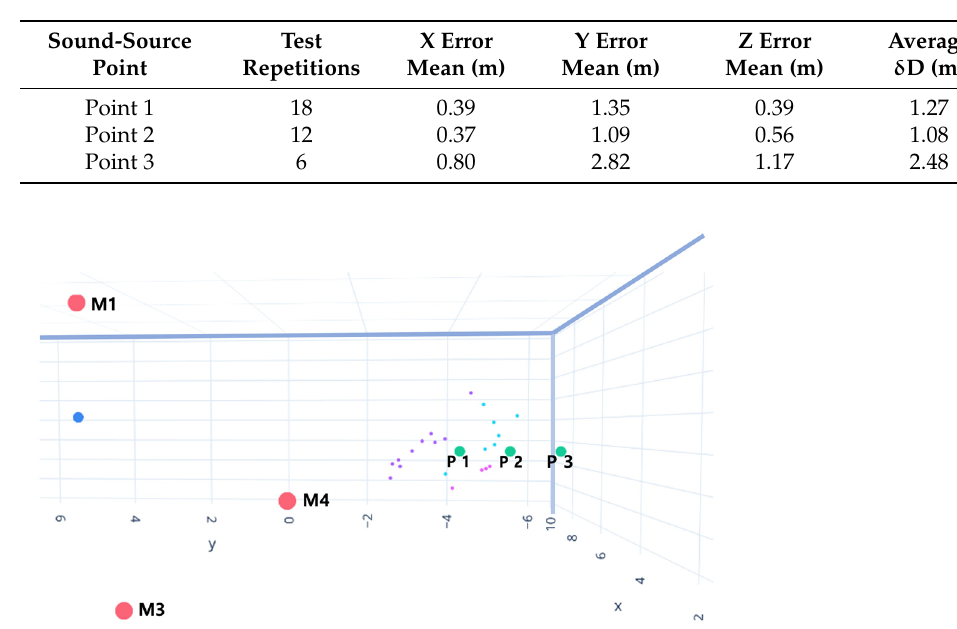
Table 6. Results of the interior validation test 2.